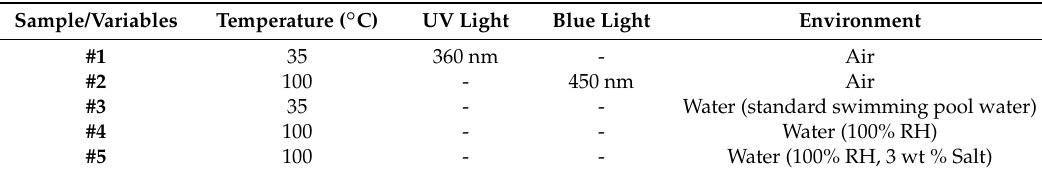
Table 1. Experimental exposure conditions .